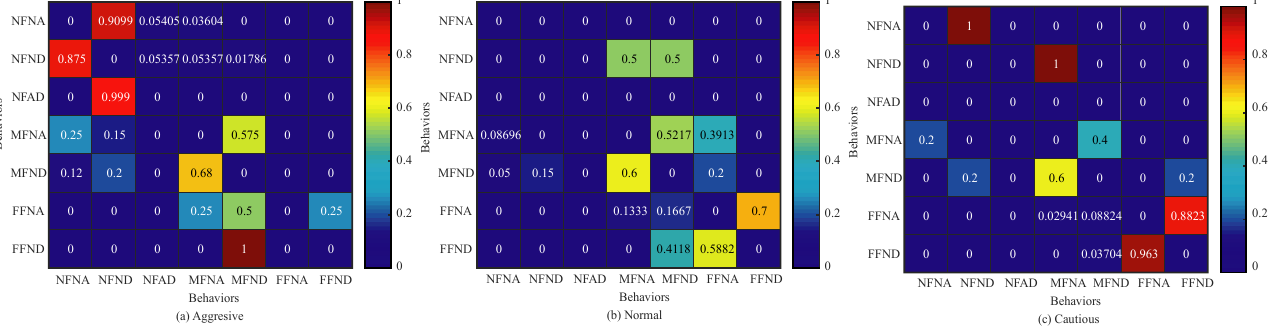
Figure 17. Transition probabilities between the behaviors involved in the selected seven features for ( a ) aggressive, ( b ) normal, and ( c ) cautious driving styles, respectively.